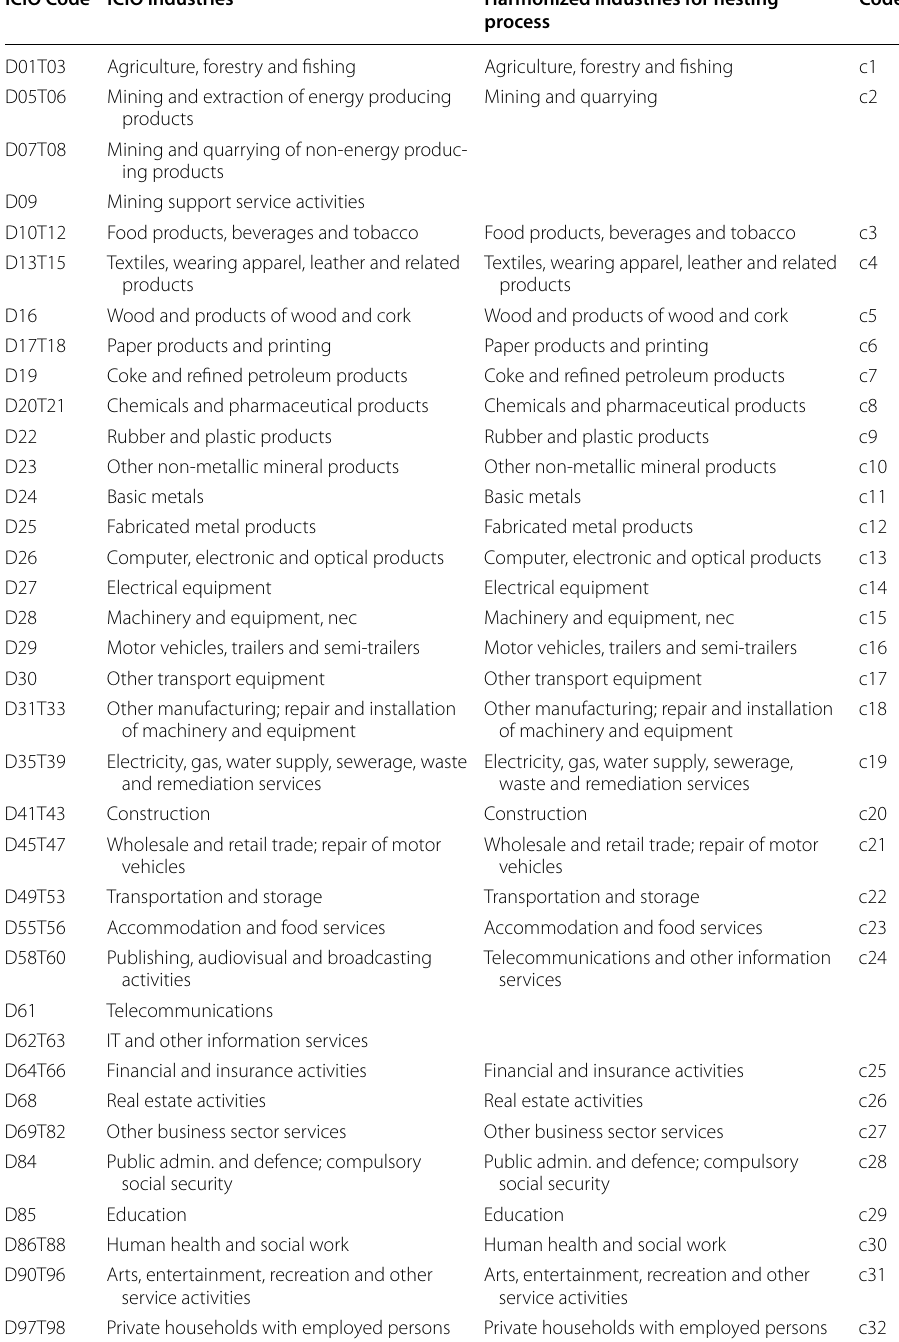
Table 1 Sectorial correspondences for ICIO tables. Source: own elaboration ICIO Code ICIO industries Harmonized industries for nesting process